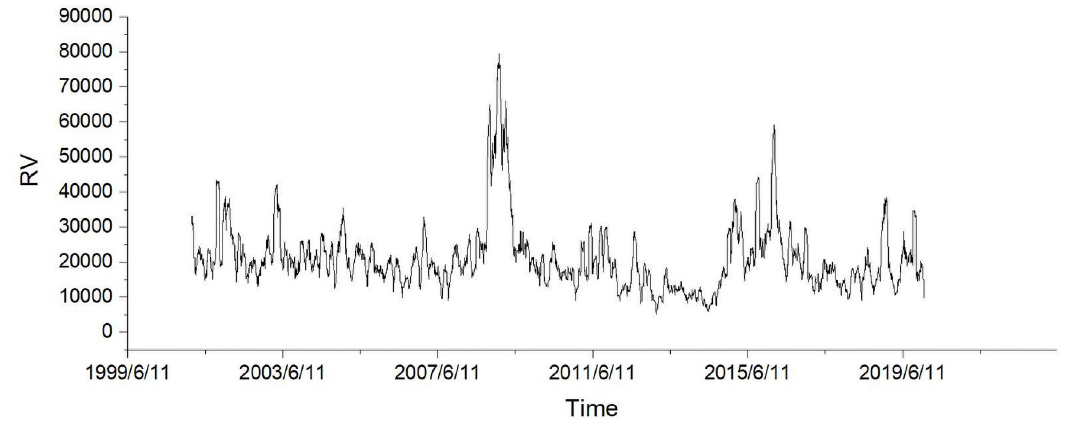
Fig 3. Daily realized variance